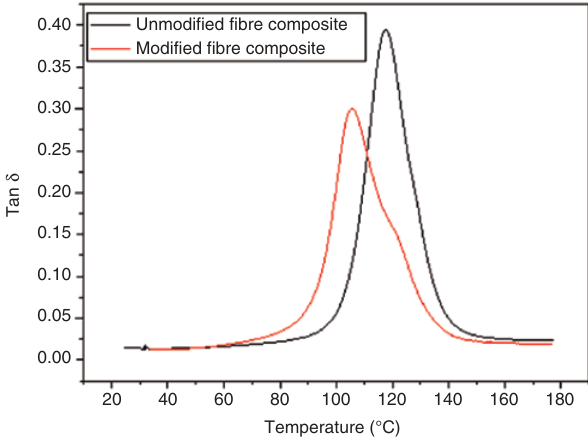
Figure 10: Strain-stress curve of control and grafted single fibers.